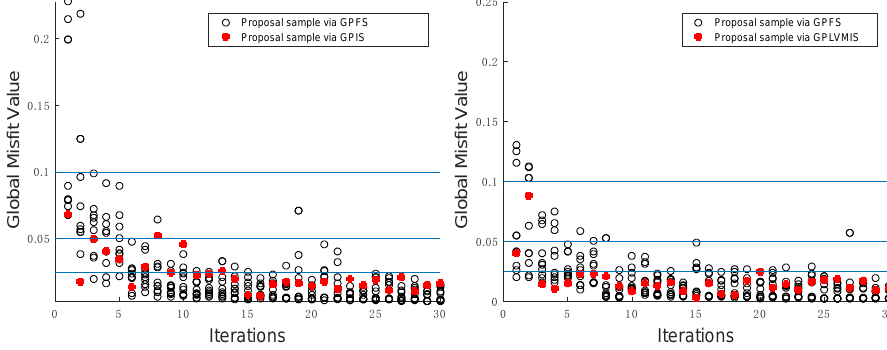
Figure 7. The visualization of 11 proposal samples from GP-VARS and